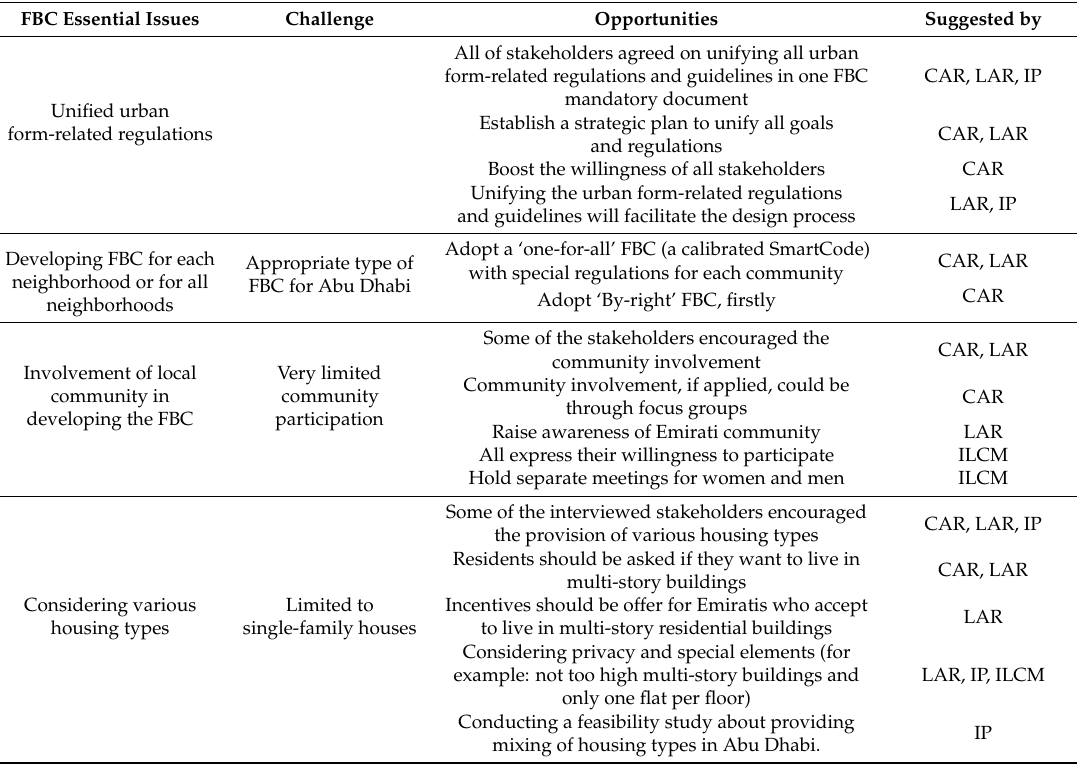
Table 5. The stakeholders’ opinions about the challenges and opportunities facing the application of the proposed localized FBC for Abu Dhabi new urban